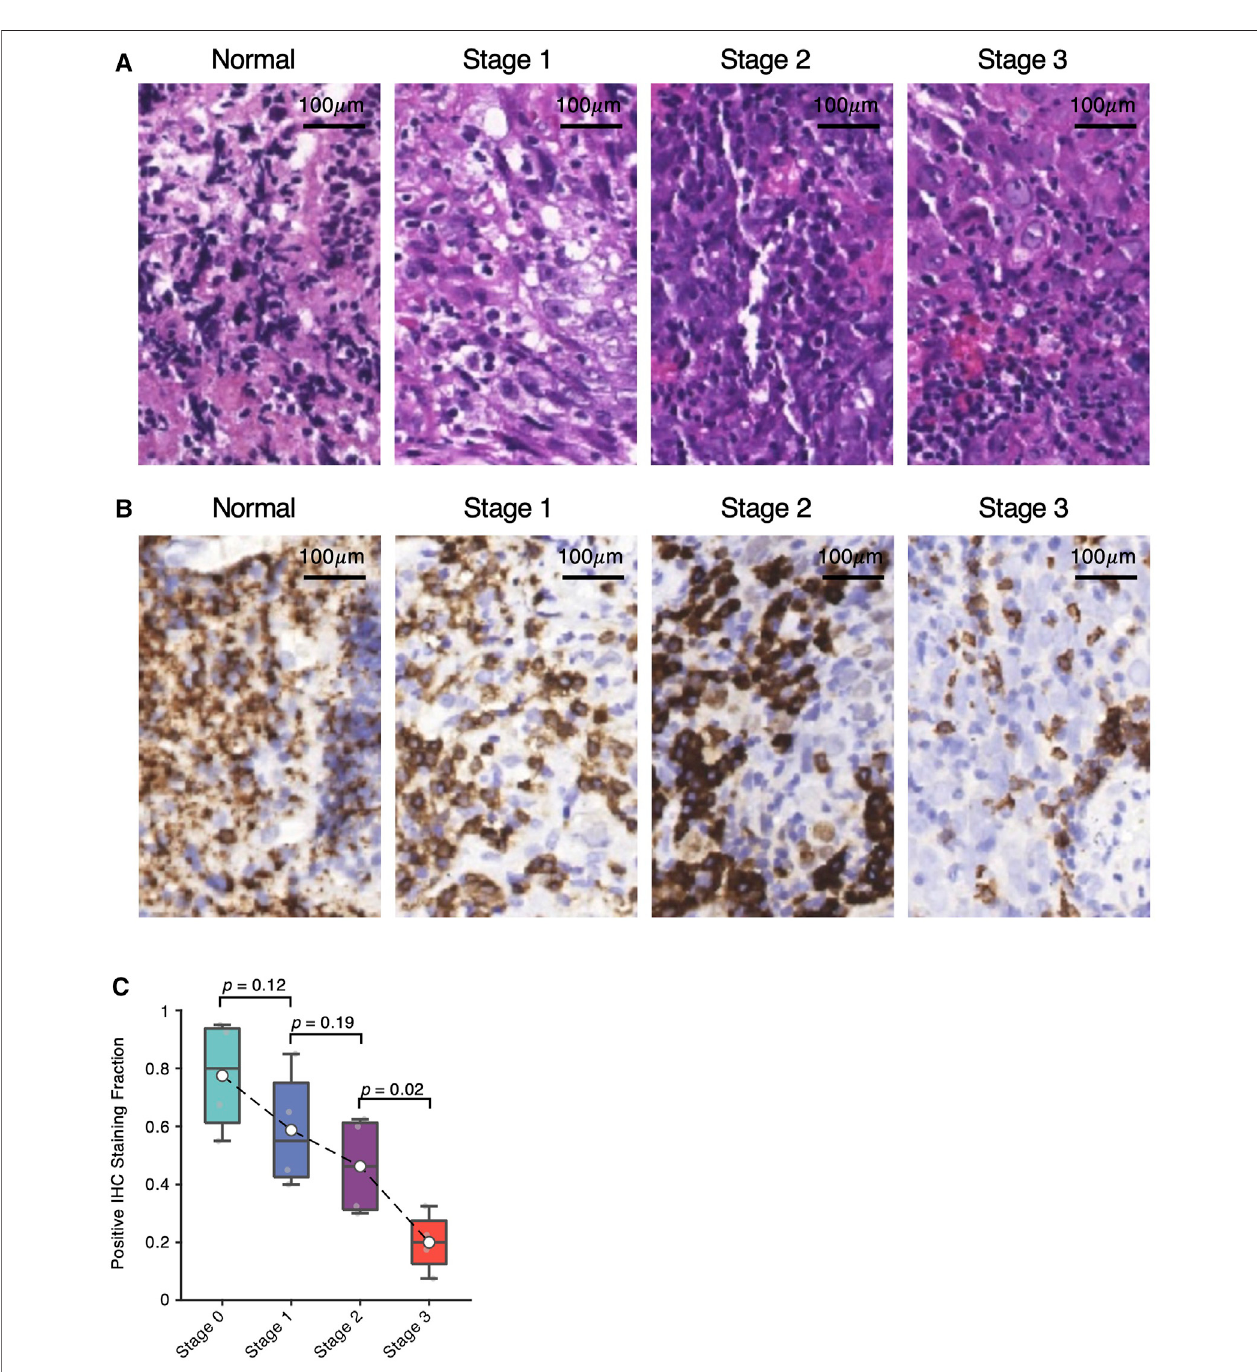
FIGURE5| ValidationofB-celldepletionviaimmunohistochemistrystaining. (A) Hematoxylinandeosin(HE)stainingimagesofStageone,twoandthreeNPCsand non-NPC adjacent normal samples. (B) Corresponding anti-CD20 immunohistochemistry (IHC) staining images of Stage one, two and three NPCs and non-NPC adjacent normal samples. (C) Fraction of IHC positive staining shown in (B) with signi fi cance estimated by t -test.